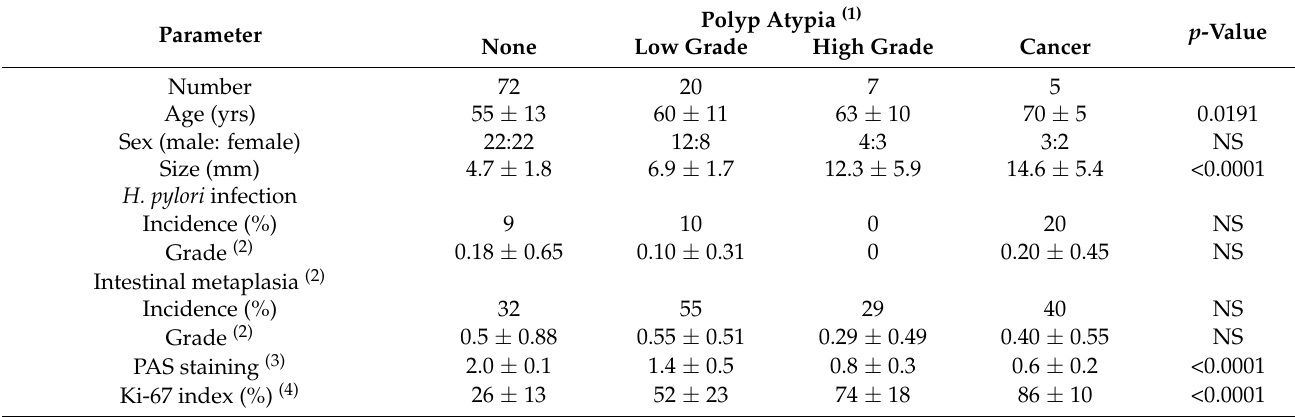
Table 1. Relationship between polyp atypia and H. pylori infection or proliferation.